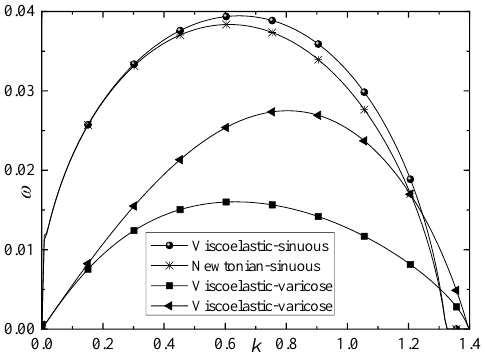
Figure 3. Temporal instability of an Oldroyd-B and Newtonian fluid sheet in the electric field for sinuous and varicose modes.